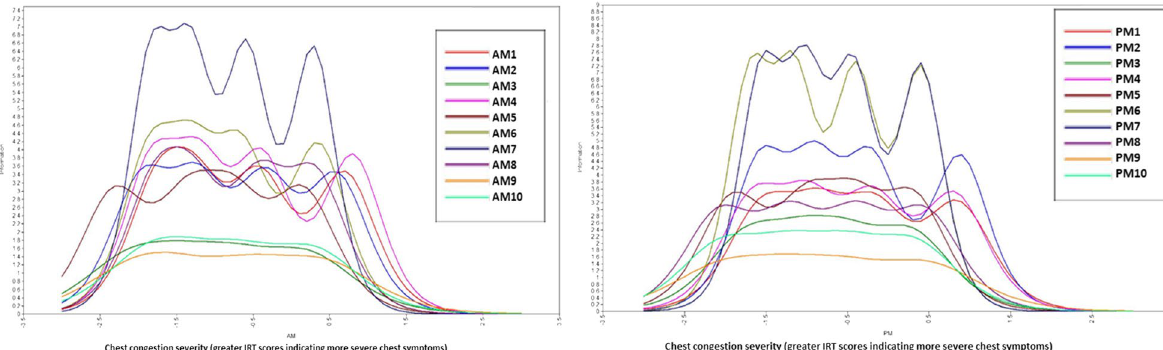
Fig. 4 IICs for AM and PM items for the total study sample